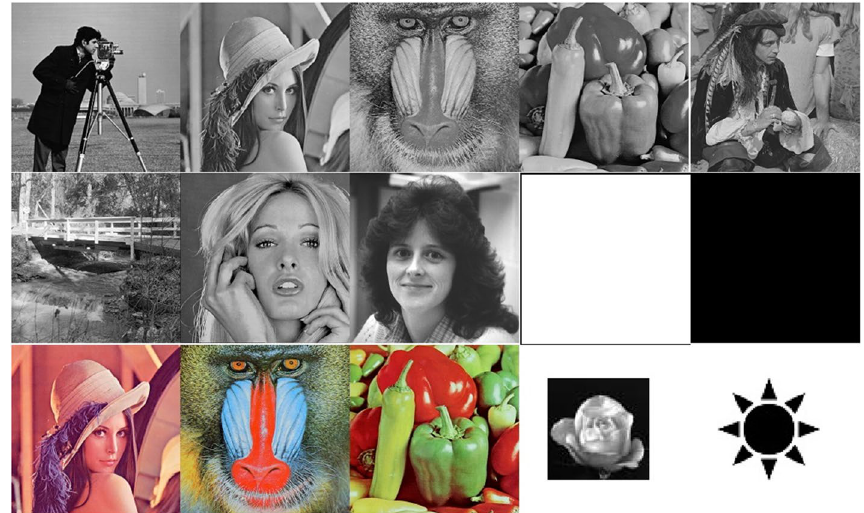
Fig. 4 Images: up to down. From left to right: first row: cameraman.tif, Lena.tif, Mandril_gray.tif, Pepper.tif, Pirate.tif, second row: Walkbridge.tif, Woman_blonde.tif, Woman_blackhair.tif, White_Page.tif, Black_Page. tif, third row: Lena_Color.tif, Mandril_Color.tif, and Pepper_Color.tif (grayscale and color host images of size 512 512), Logo1.jpg and Logo2.jpg (Grayscale images of size 64 ×